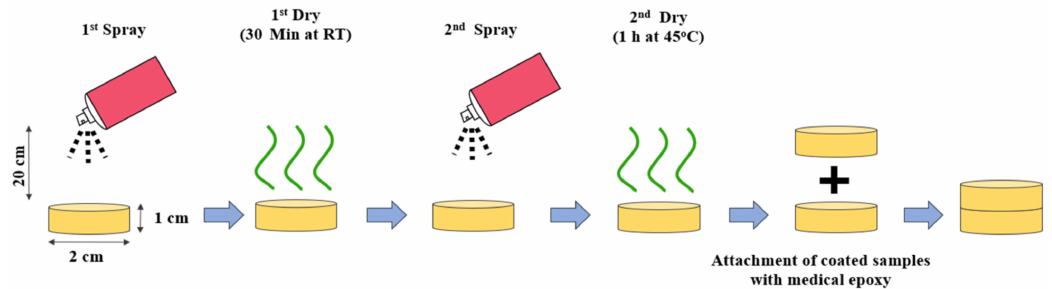
Figure 8. Spray drug coating technique on the silicone surface. Initially, drug solution was applied on the silicone surface followed by dry 30 min at RT. After drying, the drug solution was sprayed a second time and then dried for removal of the residual solution [68].